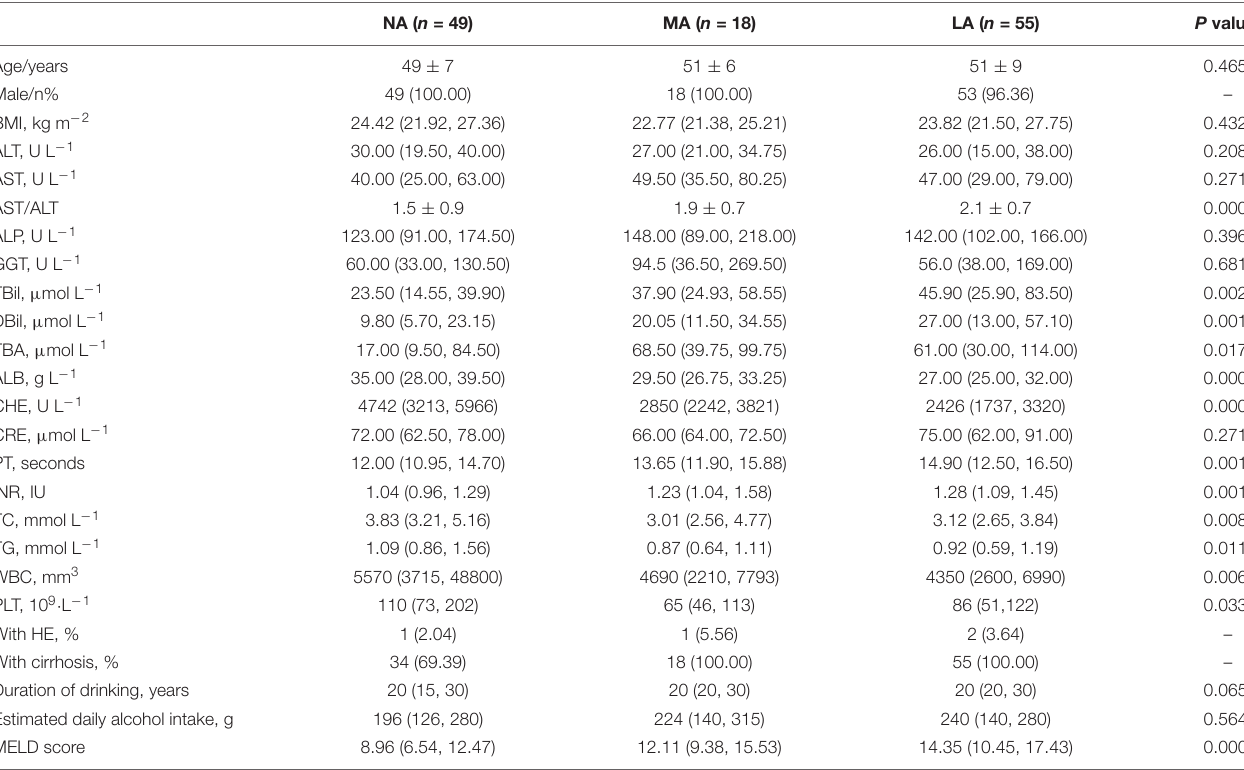
TABLE 2 | Comparison of characteristics of NA, MA, and LA